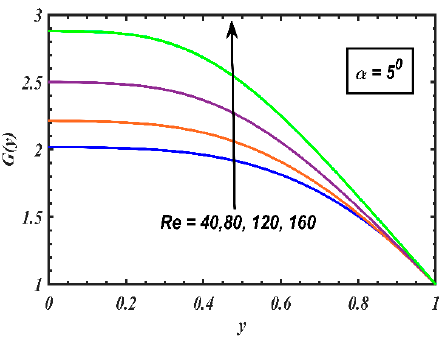
Figure 2. Variation of G(y) in diverging channel for Re = 40, 80, 120, 160 and Ec = 0.5, Pr = 5, α = 5 0 , H = 0.